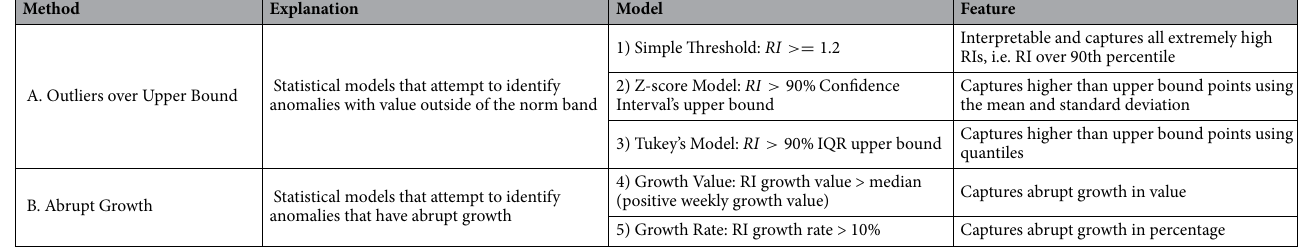
Table 5. Five Statistics Models used for Anomaly Detection.